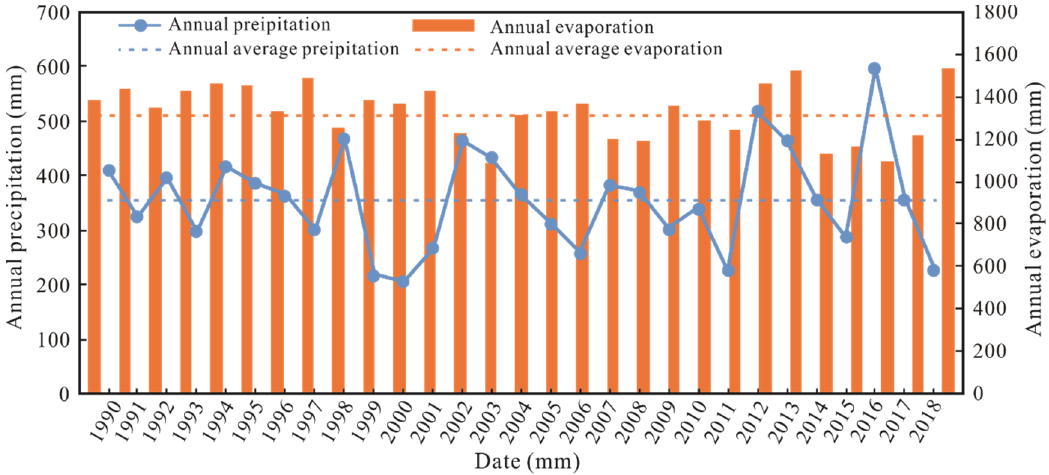
Figure 2. Variation of the annual precipitation and evaporation over a multiyear period.